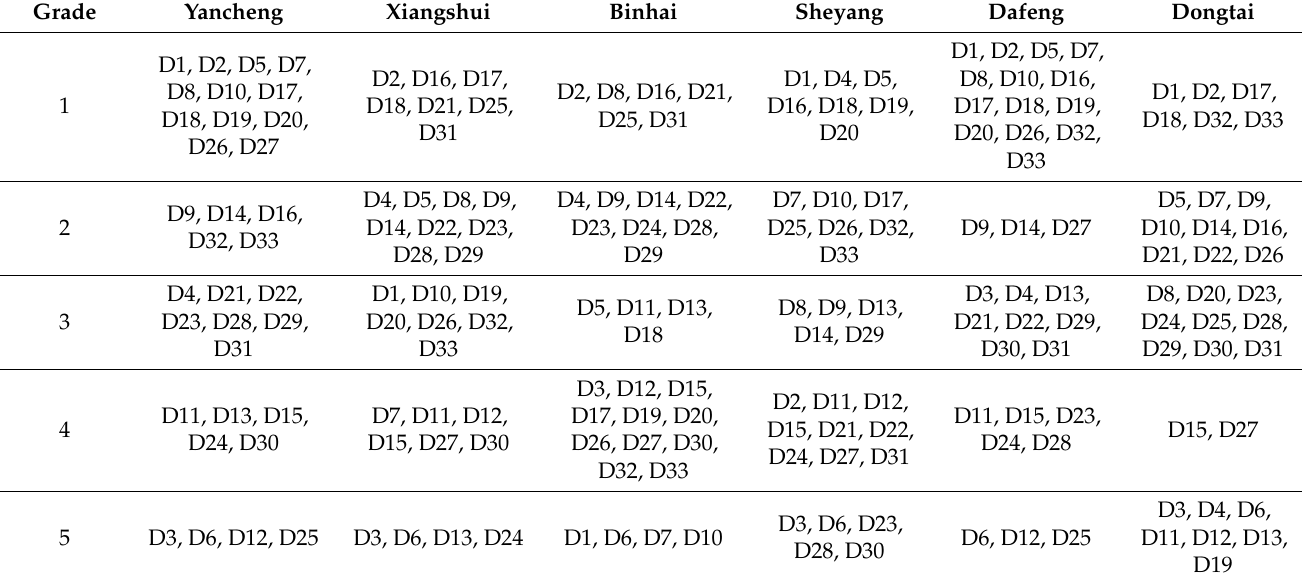
Table A3. The grading results of each